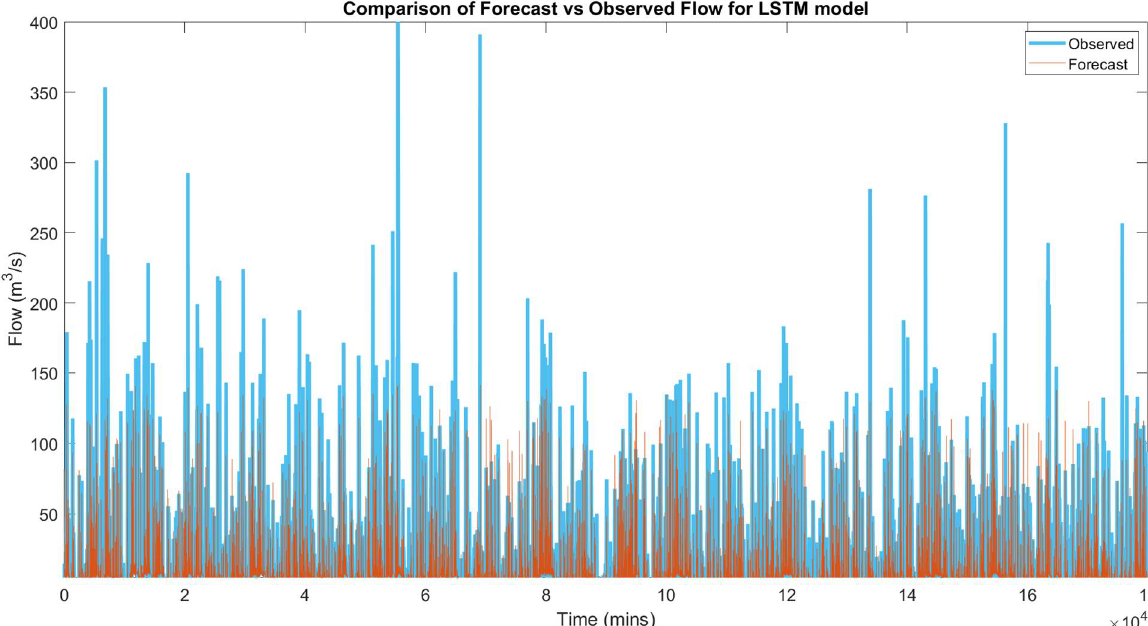
Figure 8. Graph of LSTM observed flow vs. simulated flow. Table 1. Best LSTM and ANN models for prediction.